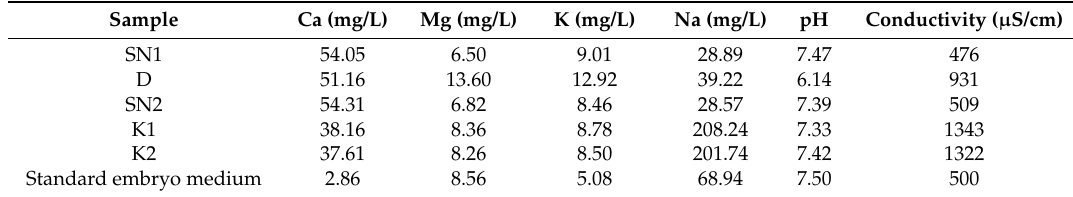
Table 2. Measurements of pH, conductivity and the concentration of four major cations in the field water samples and standard embryo